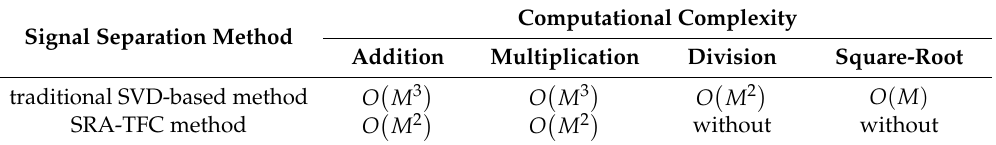
Table 2. Comparisons of the computational complexities between two signal separation methods.